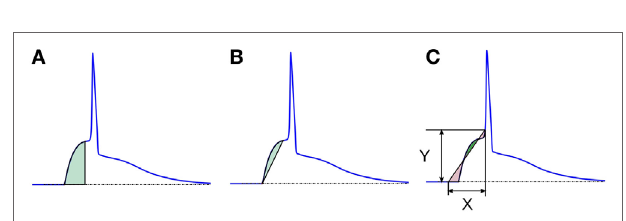
FIgURe 8 | Different schemes of area based convexity measures: (A) area under the foot, (B) area between the foot and the line joining the foot onset and EOF, and (C) area between the foot and a predefined line having width X and height Y. The areas shaded with green are measured positive and those shaded red are measured negative. For details, see text.